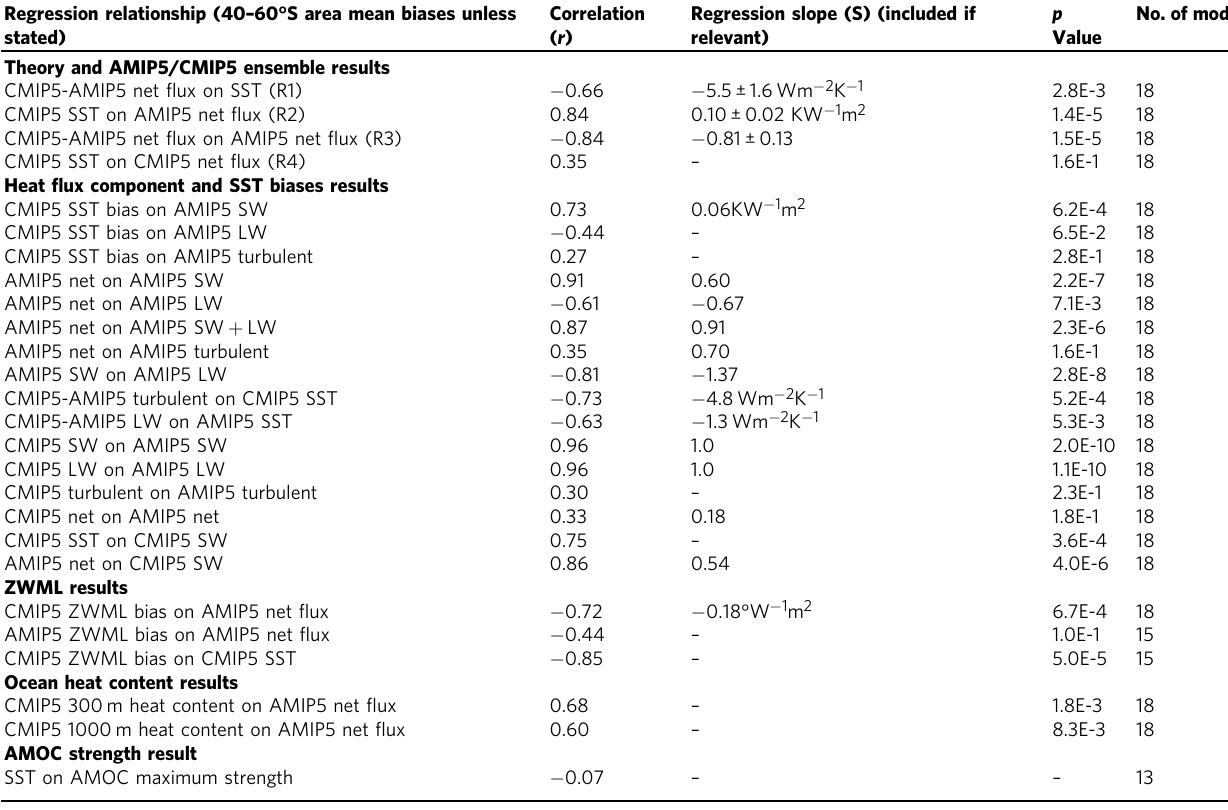
All fl uxes are net downward surface fl uxes. See Supplementary Table 1 for the individual models in each model set AMOC is Atlantic meridional overturning circulation, SW is short-wave radiation, LW is long-wave radiation, turbulent is total turbulent fl ux, ZWML is zonal wind maximum